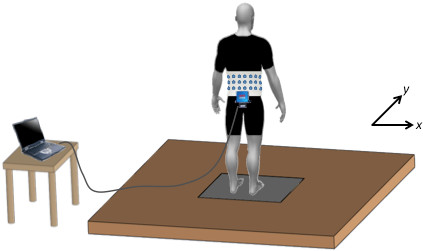
Illustration of experimental set-up.